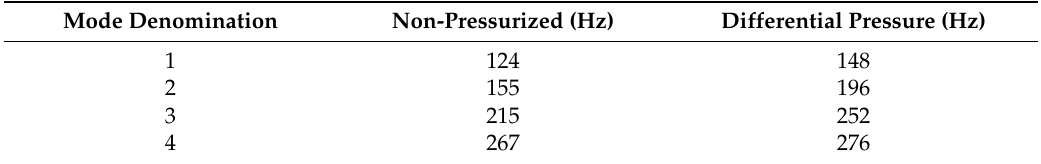
Table 2. Frequency shifting of the resonances identified in both pressurized states in specimen 1.